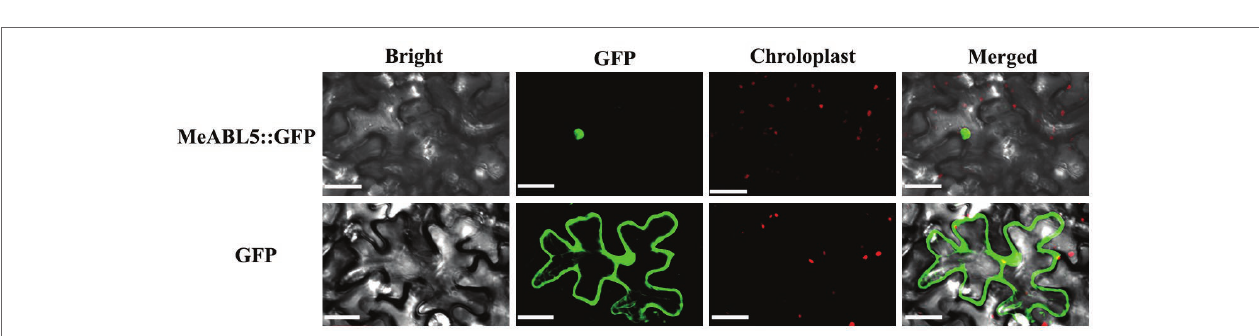
FIGURE 3 | Phylogenetic analysis of MeABL5 with bZIP proteins from cassava and Arabidopsis. A total of 77 bZIPs from cassava, 75 bZIPs from Arabidopsis, and MeABL5 were used to create the NJ tree with 1,000 bootstraps using MEGA software from CLUSTAL W alignments. The bZIP proteins are grouped into 10 subfamilies (A, B, C, D, E, F, G, H, I, and S), and MeABL5 was classified into subfamily A.